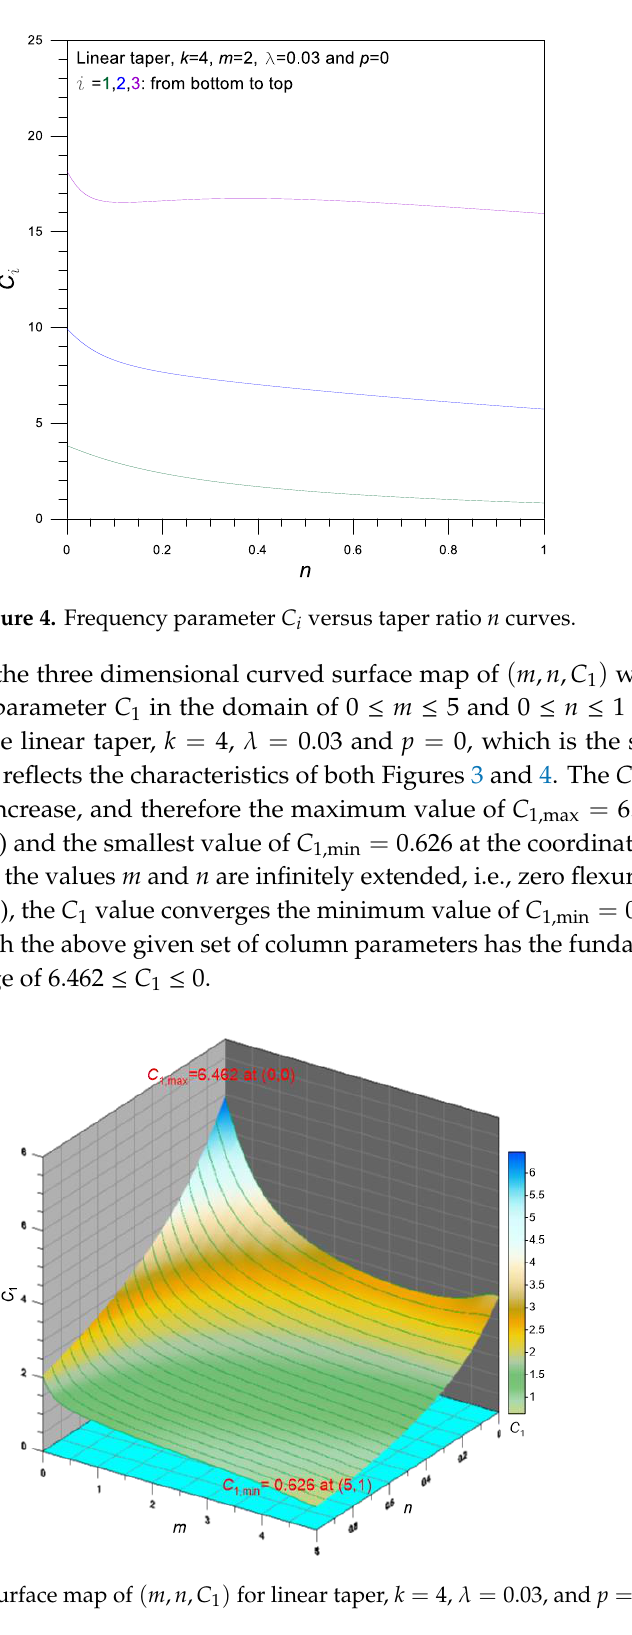
Figure 6. Frequency parameter 𝐶 𝑖 versus volume ratio 𝜆 curves.